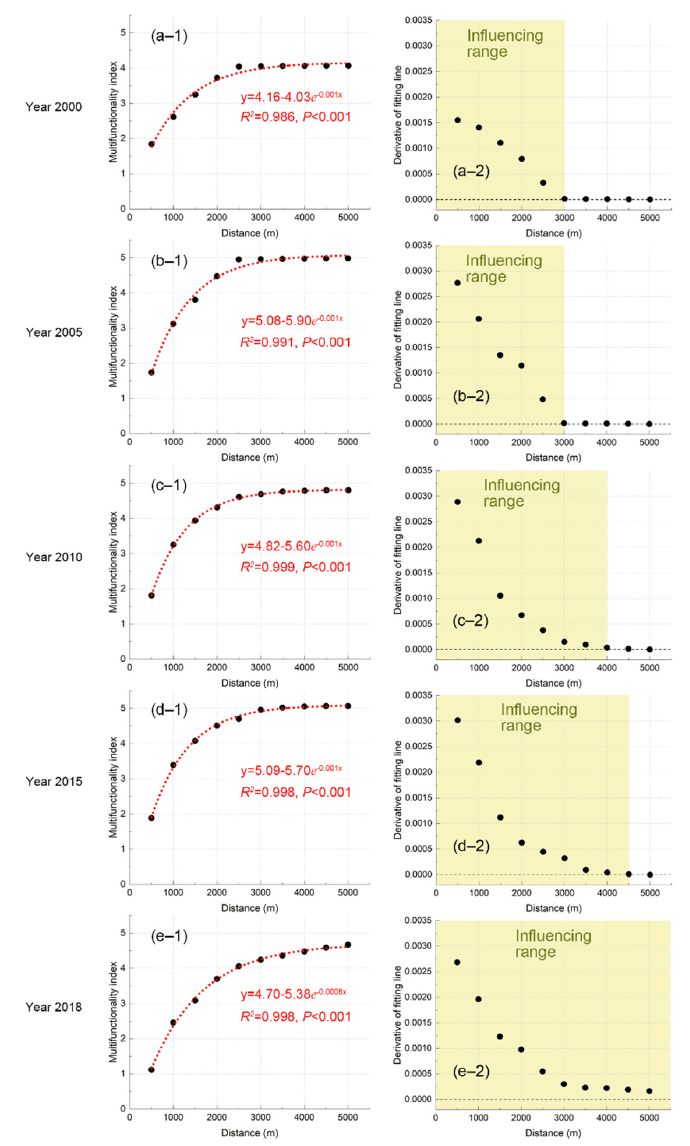
Figure 7. The change of forest landscape multifunctionality in the urban periphery of Liaoyuan city from 2000 to 2018. Panels ( a-1 , b-1 , c-1 , d-1 , e-1 ) show the change of multifunctionality index with the distance. Panels ( a-2 , b-2 , c-2 , d-2 , e-2 ) show changes in the derivative of multifunctionality index with the distance.